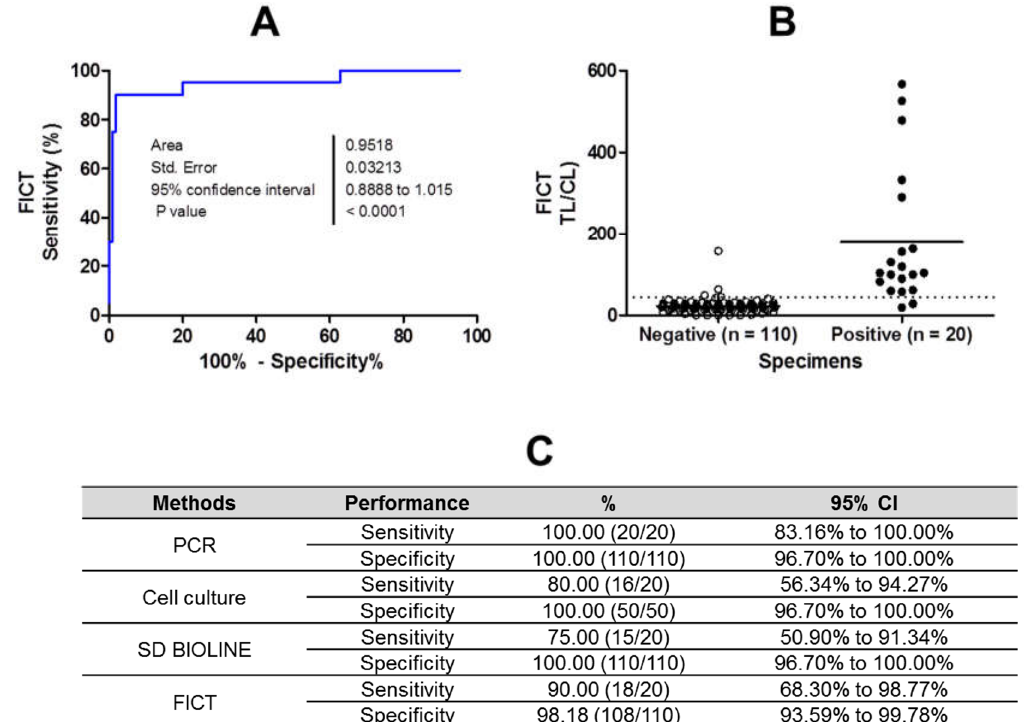
Figure 7. Clinical validation of the fluorescent immunochromatographic strip test FICT with patients infected with respiratory syncytial virus (RSV). The FICT was performed with human specimens collected from patients infected with RSV ( n = 10) and patients with other diseases ( n = 50). ( A ) The cut-off value was determined based on the receiver operating characteristic (ROC) curve, representing the sensitivity, specificity, and 95% confidence interval (CI). ( B ) Based on ROC curve analysis, 44.21 was determined as the cut-off value to differentiate RSV infection in a clinical study. This cut-off value for the detection of RSV was applied to determine whether each sample was positive or negative for the presence of the virus, and is indicated in the graph as a dotted line. Nine RSV infection cases showed test line/control line (TL/CL) values that were higher than the threshold value. The non-RSV-infected control group ( n = 50) had no false-positive cases. ( C ) The sensitivity, specificity, and 95% confidence interval (CI) of the assays were computed for the diagnosis of RSV infection.